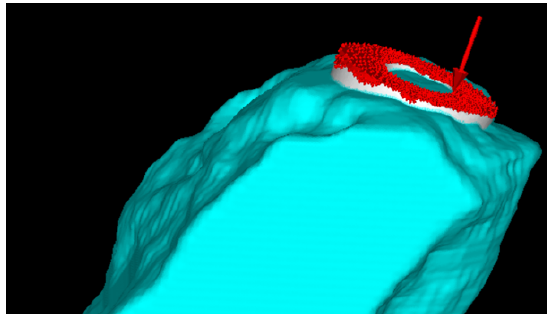
Figure 6. Loads and boundary conditions are imple- mented by selecting individual and neighboring nodes and providing a direction in the form of a